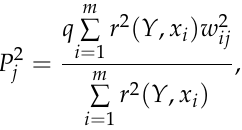
Table 3. Fitting results of the volume growth models in different forest types.